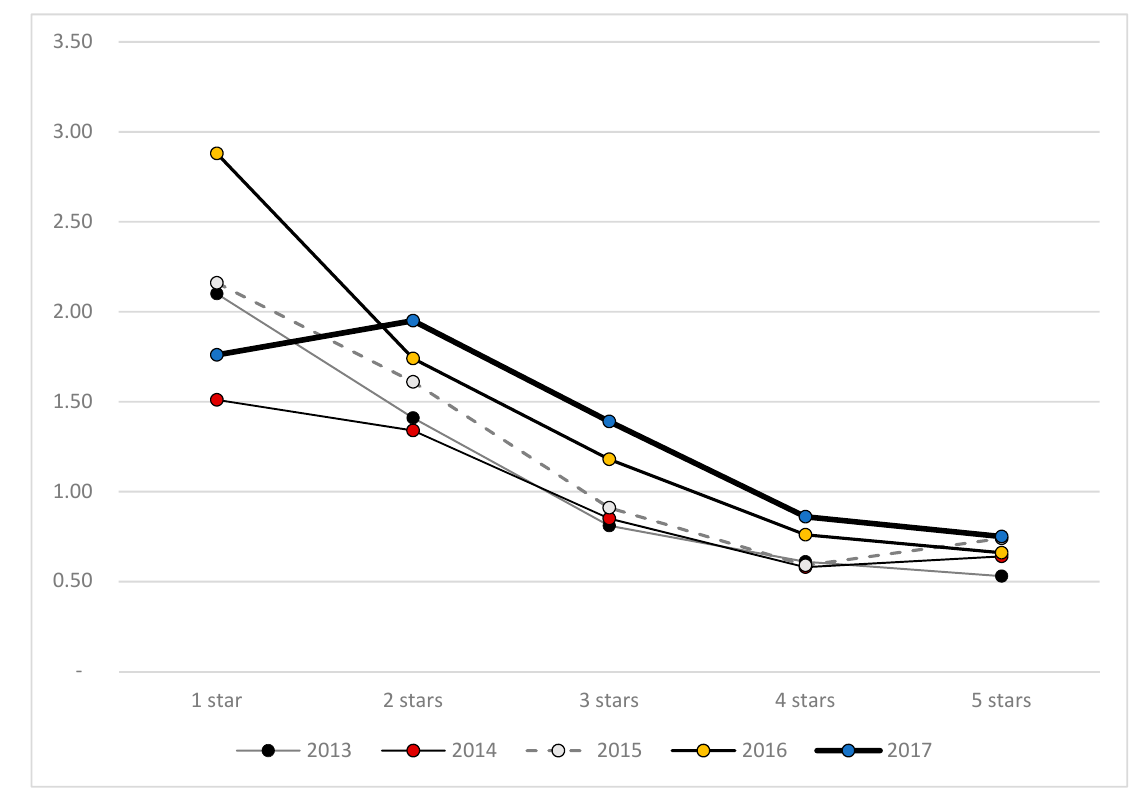
Figure 7. Current Ratio, by the number of stars.